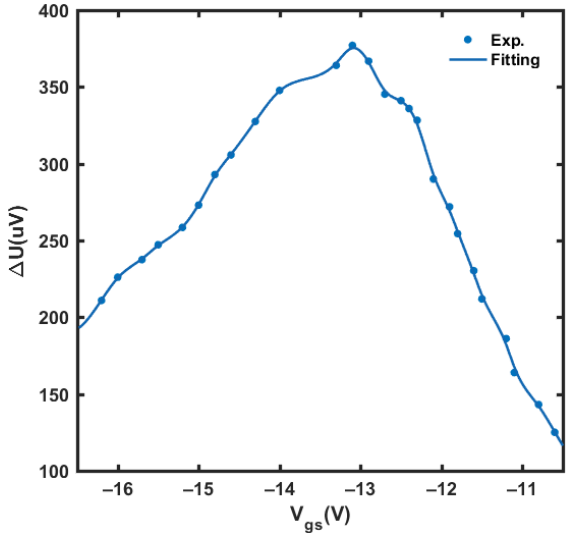
Figure 8. ( a ) The transfer and transconductance characteristics of the fabricated DC GaN HEMT. ( b ) The output characteristics of the fabricated DC GaN HEMT.